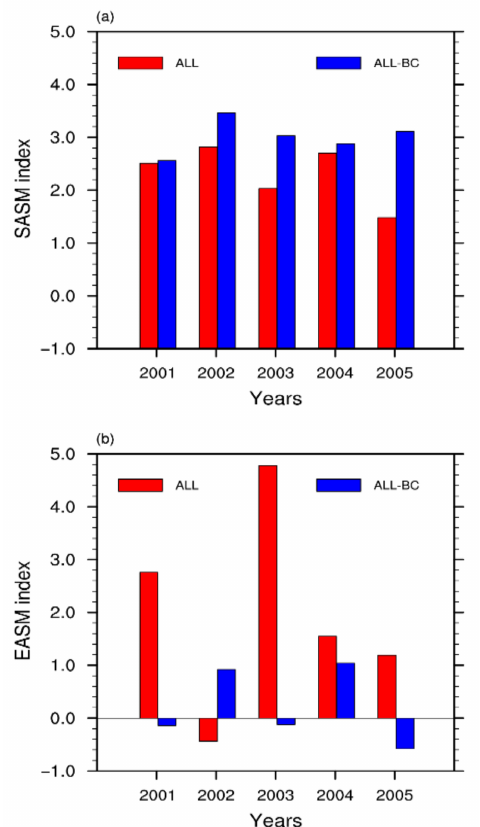
Figure 10. Changes in the ( a ) SASM and ( b ) EASM index from 2001–2005. The red and blue bars